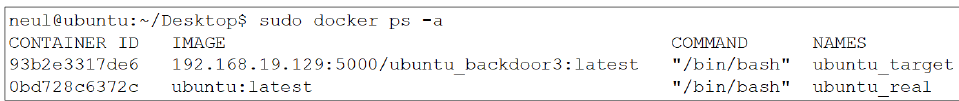
Figure 31. ubuntu_target docker container list